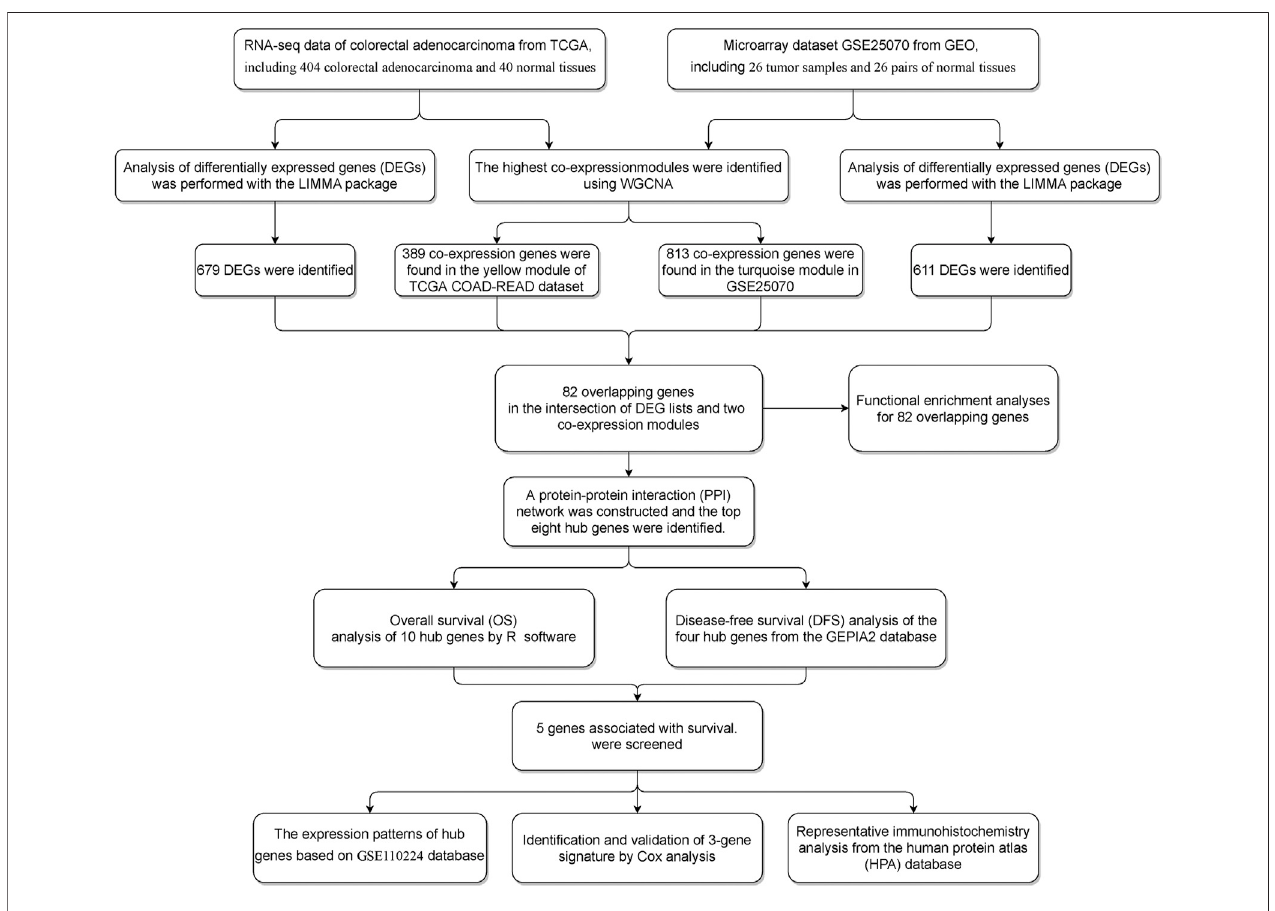
FIGURE 1 | Work fl ow of the study